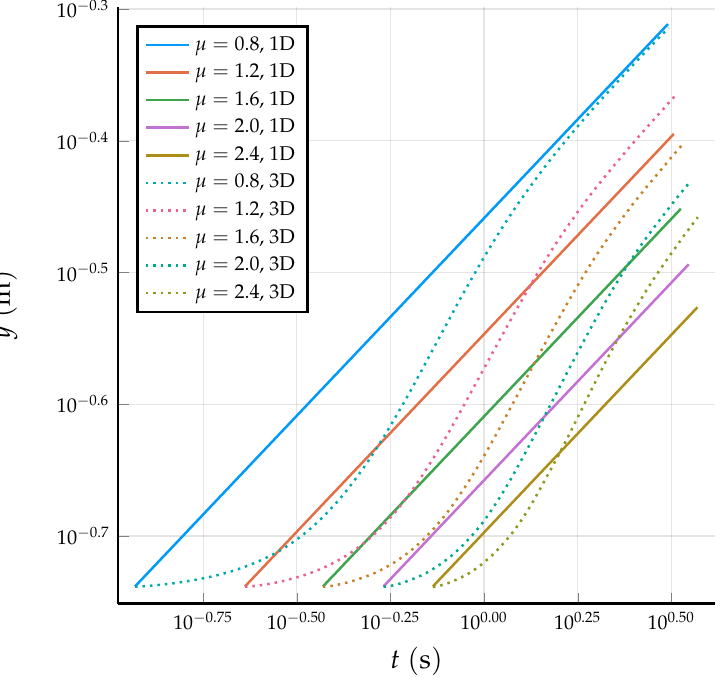
Figure 6. An overlay of propagation distances for the 1D model and 3D simulations at various